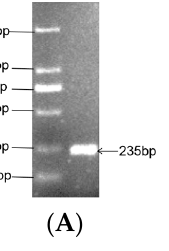
Figure 1. Cloning and sequence analysis of pitaya hairpin sequence MIR396b : ( A ) electrophoresis of cloned hpo-miR396b precursor; ( B ) alignment of the clone with the transcriptome. The RNA fold analysis of the hairpin sequence revealed that it forms a typical stem-loop structure with hpo-miR396b and hpo-miR396b* located in the two opposite arms (shown by the red and purple line in Figure 2A). The hpo-miR396b sequence (5 ′ -UUCCACAGCUUUCUUGAACUU-3 ′ ) is located in the 5p arm of pitaya precursor miR396b ( MIR396b ). Additionally, the hpo-miR396b* read was uncovered from the RNA-seq data. Comparing the stem-loop structure of H. polyrhizus , A. thaliana , and Nicotiana tabacum MIR396b , the sequence of the two arm structure was found to be relatively conserved (Figure 2); however, their loops varied in sequence and minimum free energy ( H. polyrhizus loop dG = − 4.20 kcal/mol, A. thaliana loop dG = − 9.4 kcal/mol, N. tabacum loop dG = − 0.7 kcal/mol).